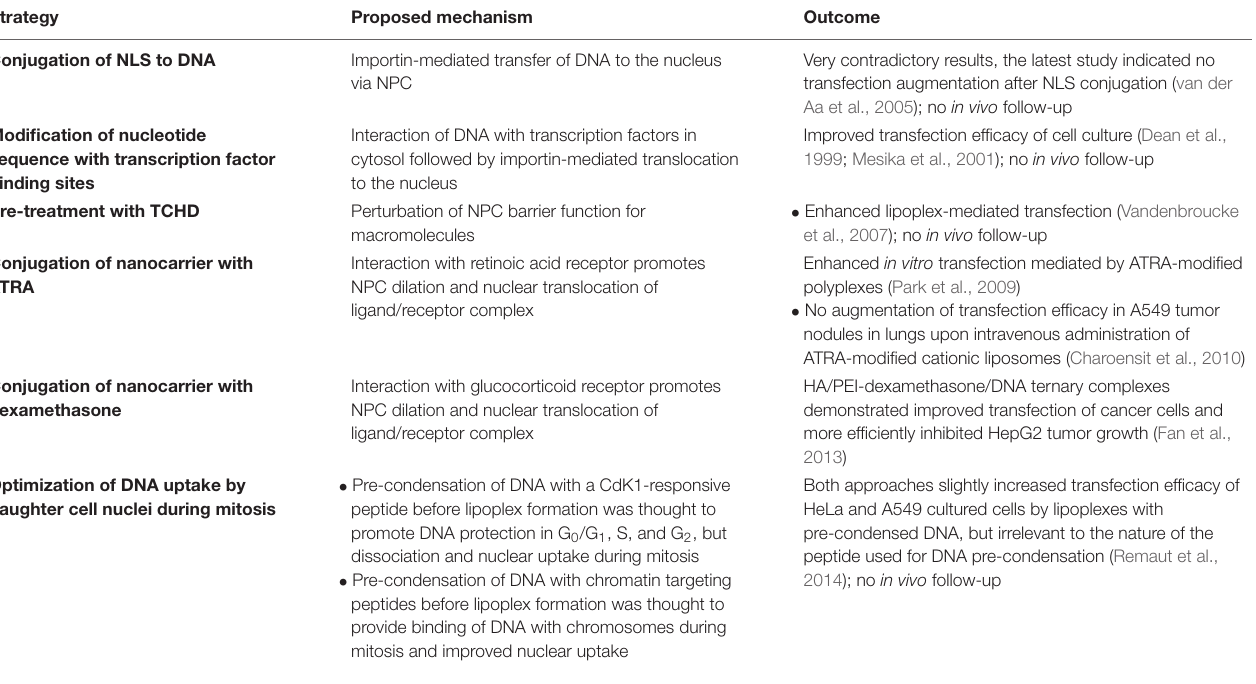
TABLE 2 | Main strategies to facilitate nuclear uptake of DNA delivered using non-viral vectors.